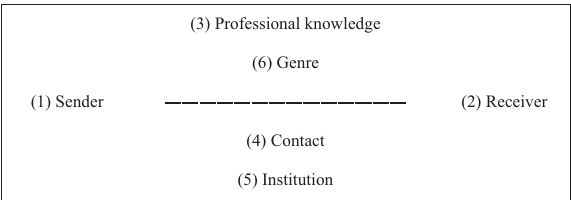
Fig. 5 Communication model in Pärl (2012b). Source: Partially modi fi ed from Pärl (2012b, p.